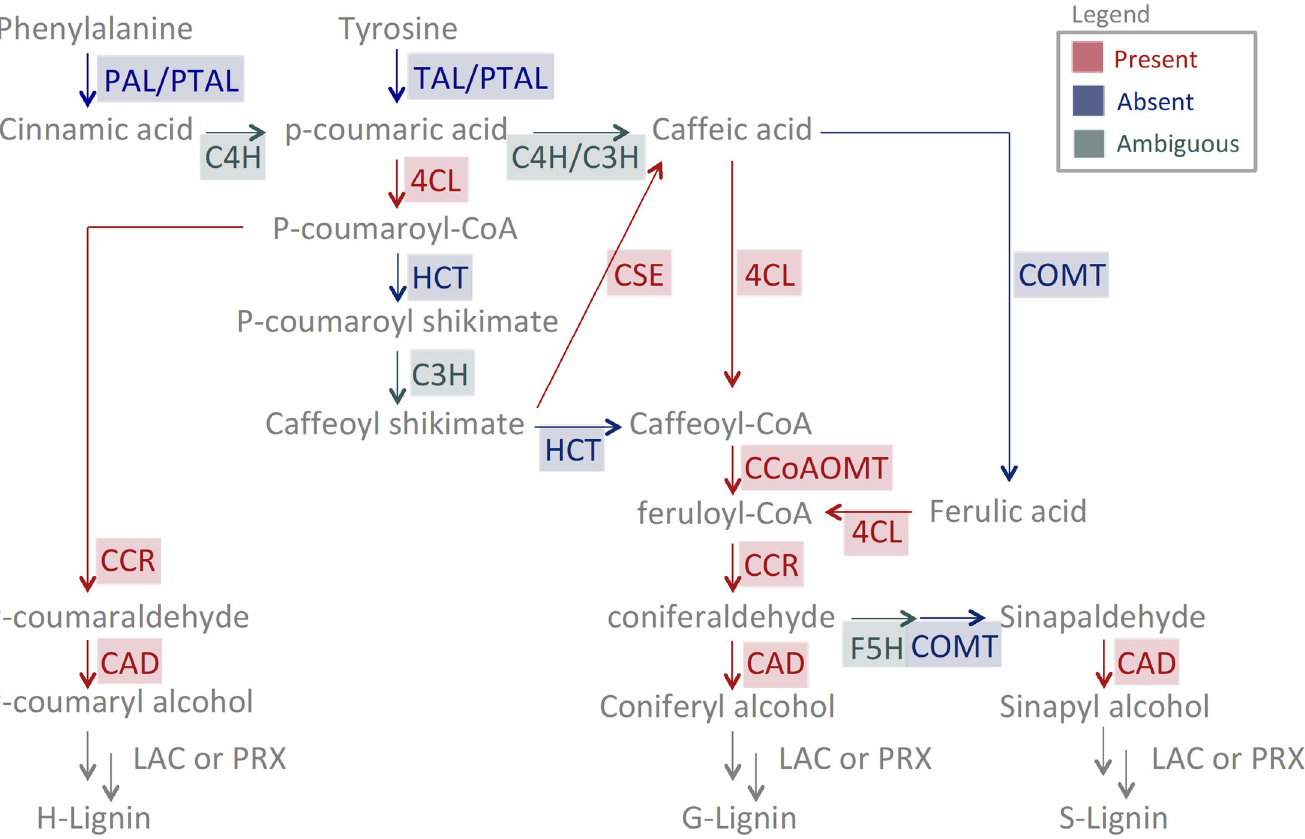
Fig 1. The presence of C . tuberculosum sequence candidates in the monolignol pathway. Red indicates presence of a putative homolog in C . tuberculosum ; blue indicates no significant hits; green indicates ambiguous presence. Note how the PTAL/PAL/TAL sequences obtained from the HMMER search were indicated as absent as all sequences found were too short, 1/4-1/3 in length relative to those in land plants. All sequences identified have genomic support except for PTAL/PAL/ TAL. Table). Moderate sequence conservation exists in substrate binding and hydroxycinnamate binding residues between 4CL candidates in C . tuberculosum (bolded) and 4CLs in land plants (identity similarity [IS] > 70% Fig 2A).